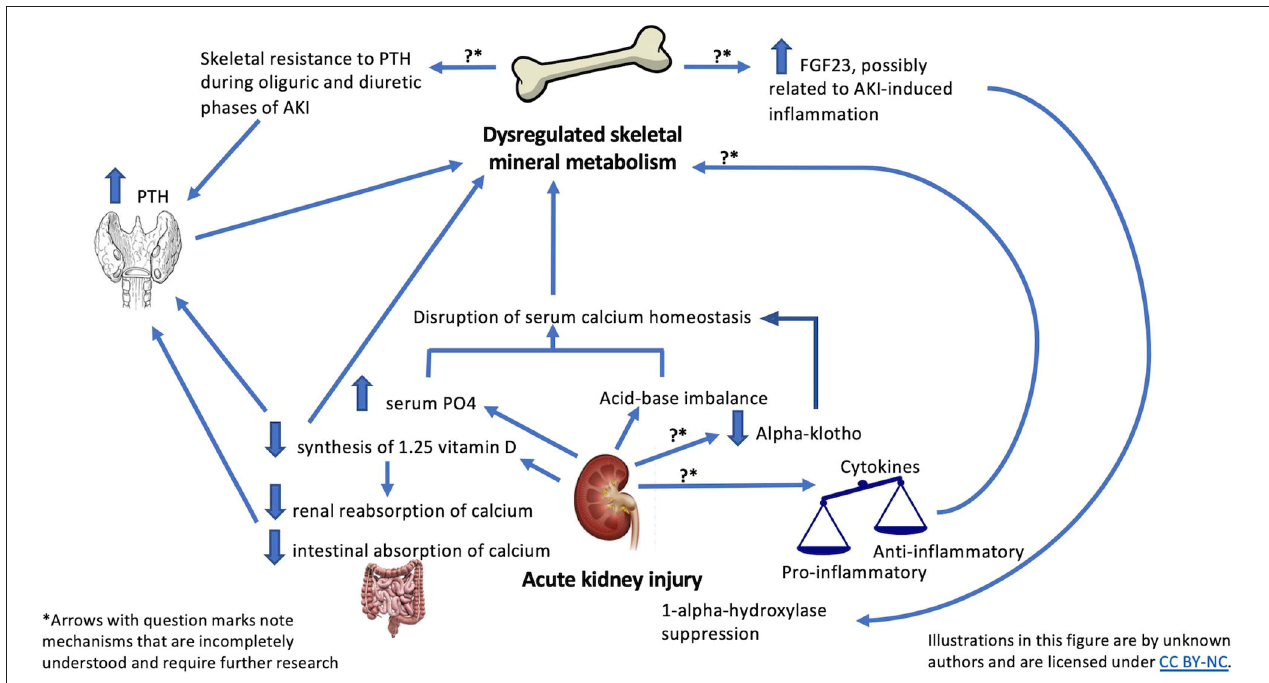
FIGURE 1 | Summary of possible mechanisms linking AKI and skeletal